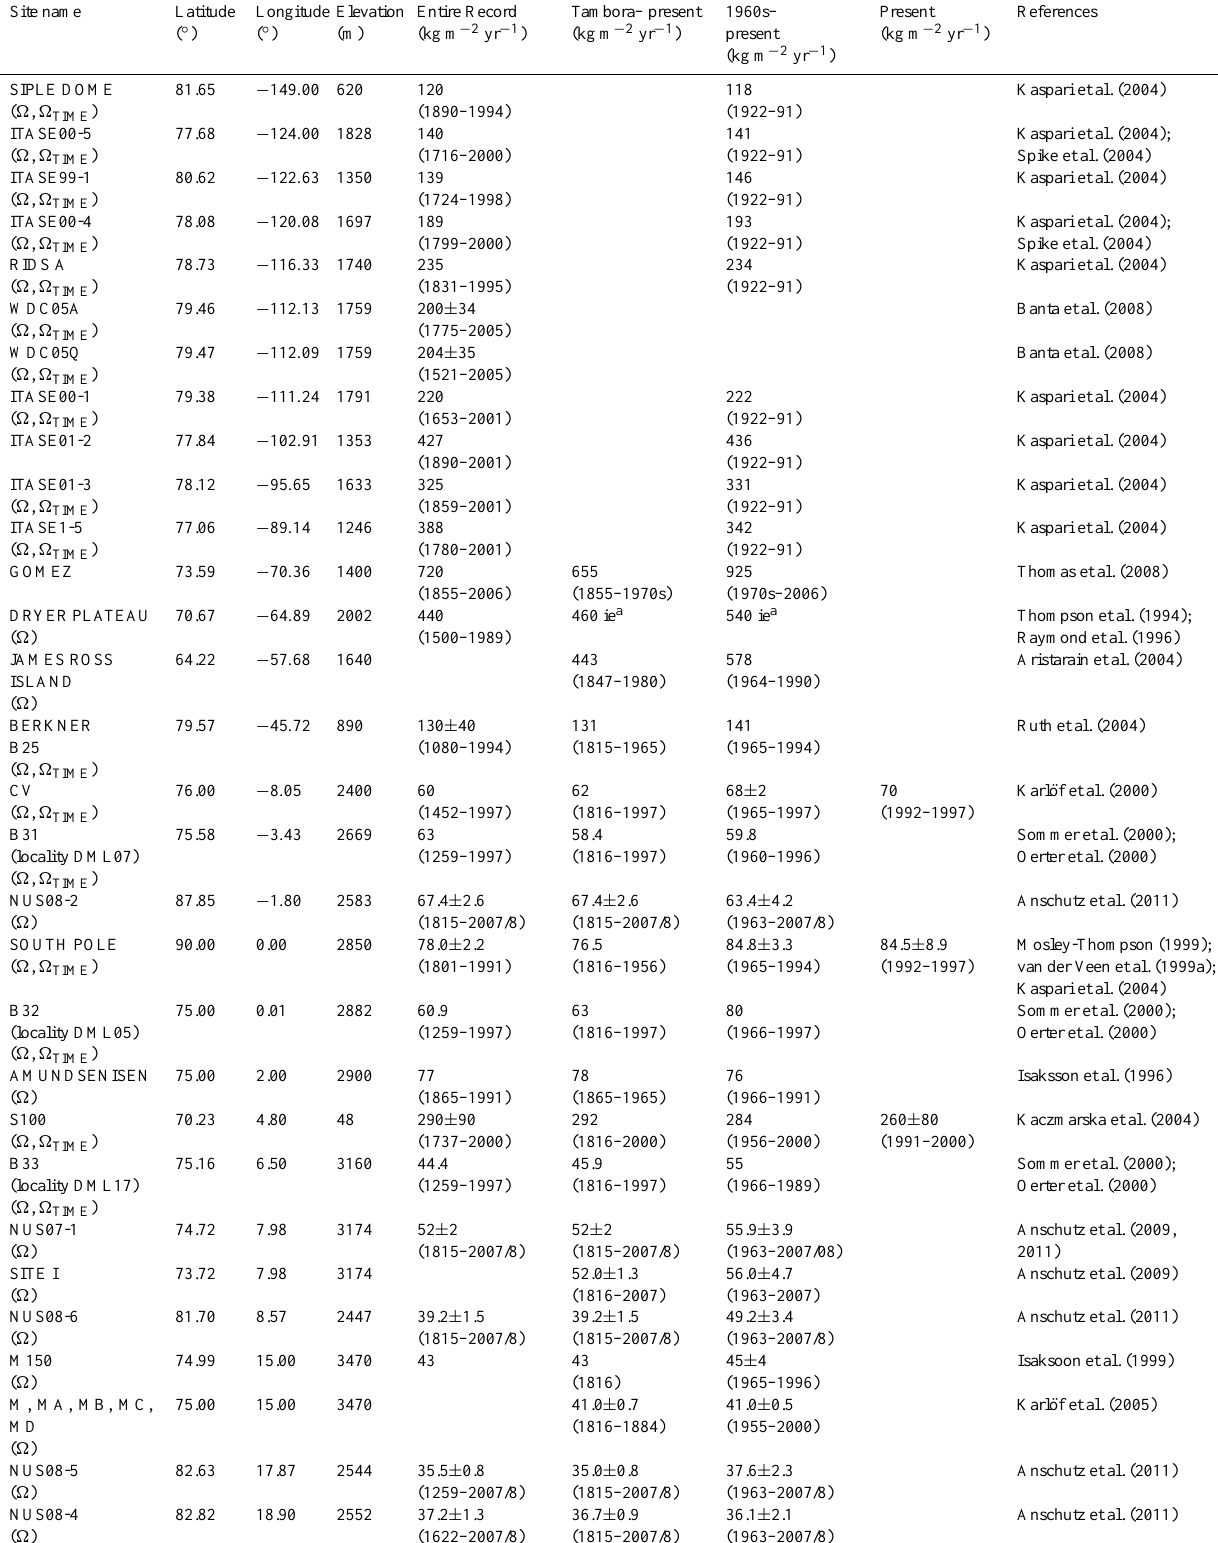
Table 1. Site information and snow accumulation